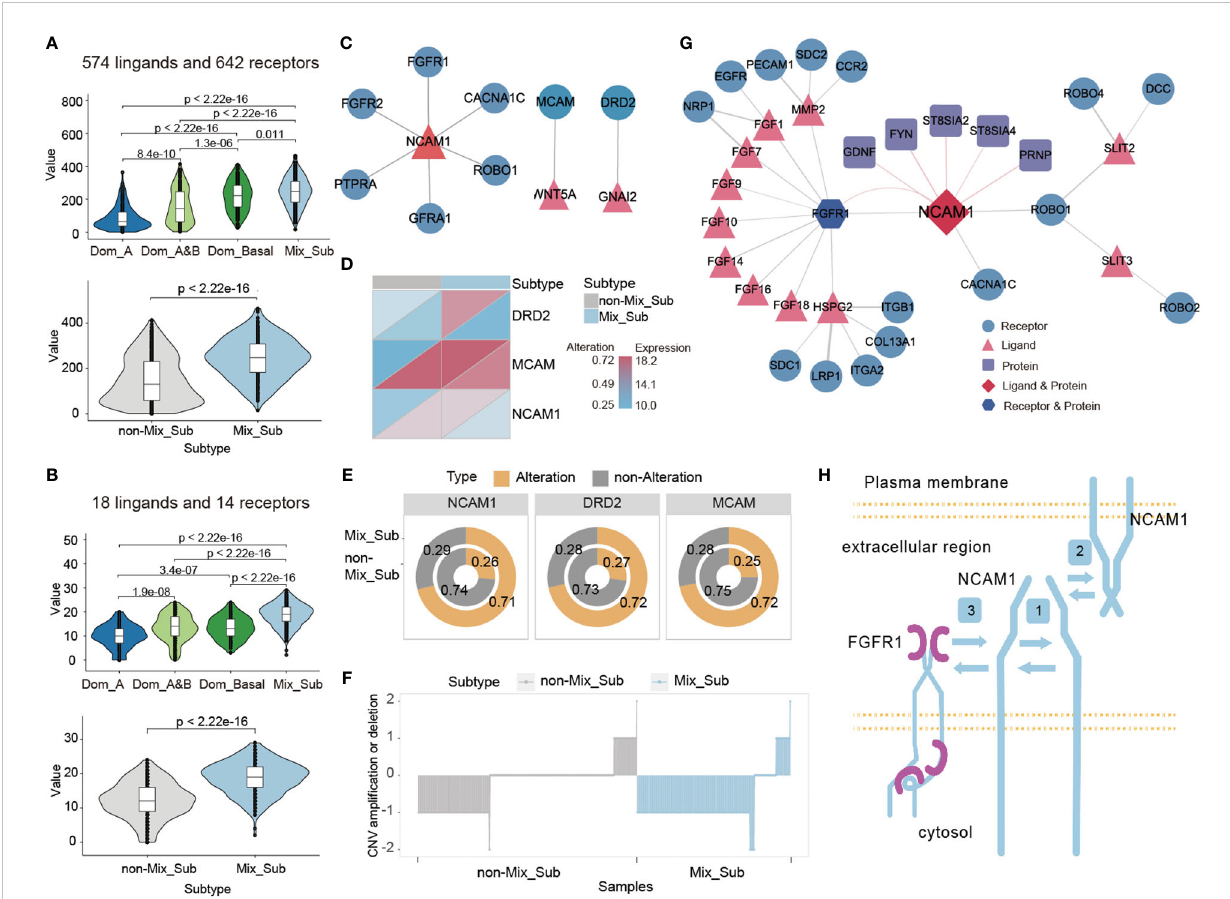
FIGURE 7 (A, B) Number of genes expressing GDTEC in 1216 and 32 subtype-speci fi c ligands and receptors in patients with different subtypes. (C) The ligand- receptor pairs of NCAM1, WNT5A and GNAI2 with high proportion of GDTEC expression in Mix_Sub subtype patients. (D) GDTEC expression and mRNA expression of NCAM1, WNT5A and GNAI2 in patients with Mix_Sub subtype and non-Mix_Sub subtype. (E) Ratio of patients with GDTEC expression of NCAM1, WNT5A and GNAI2 in Mix_Sub subtype and non-Mix_Sub subtype patients. (F) Copy number deletion of NCAM1 in patients. (G) NCAM1 ligand-receptor pairs and protein-protein interactions related to breast cancer. (H) Diagram of the cell-cell communication mechanism mediated by NCAM1-FGFR1 (Symbol 1: Cis-homophilic interactions of an NCAM1 molecule. Symbol 2: Trans-homophilic interactions between NCAM molecules on different cell membranes. Symbol 3: Interactions between NCAM1 and